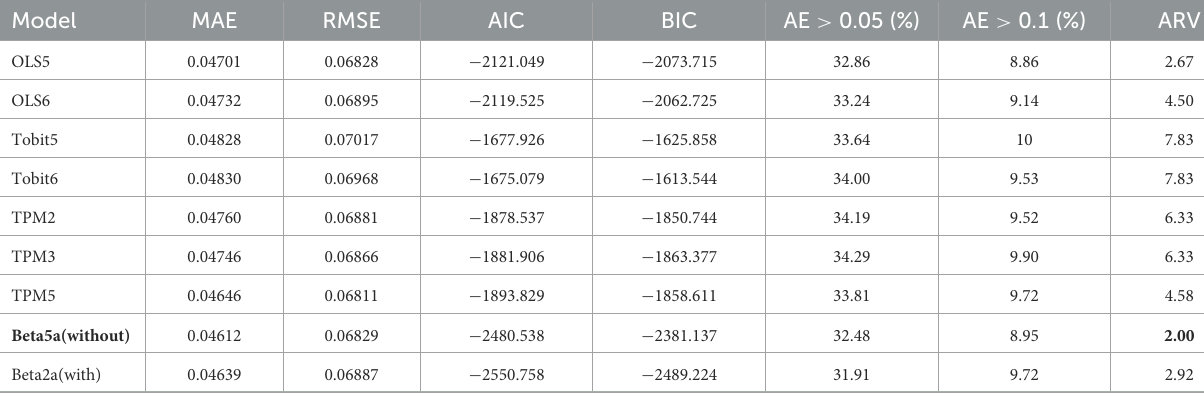
TABLE 4 Five-fold cross-validation of the best-fitting model. Model